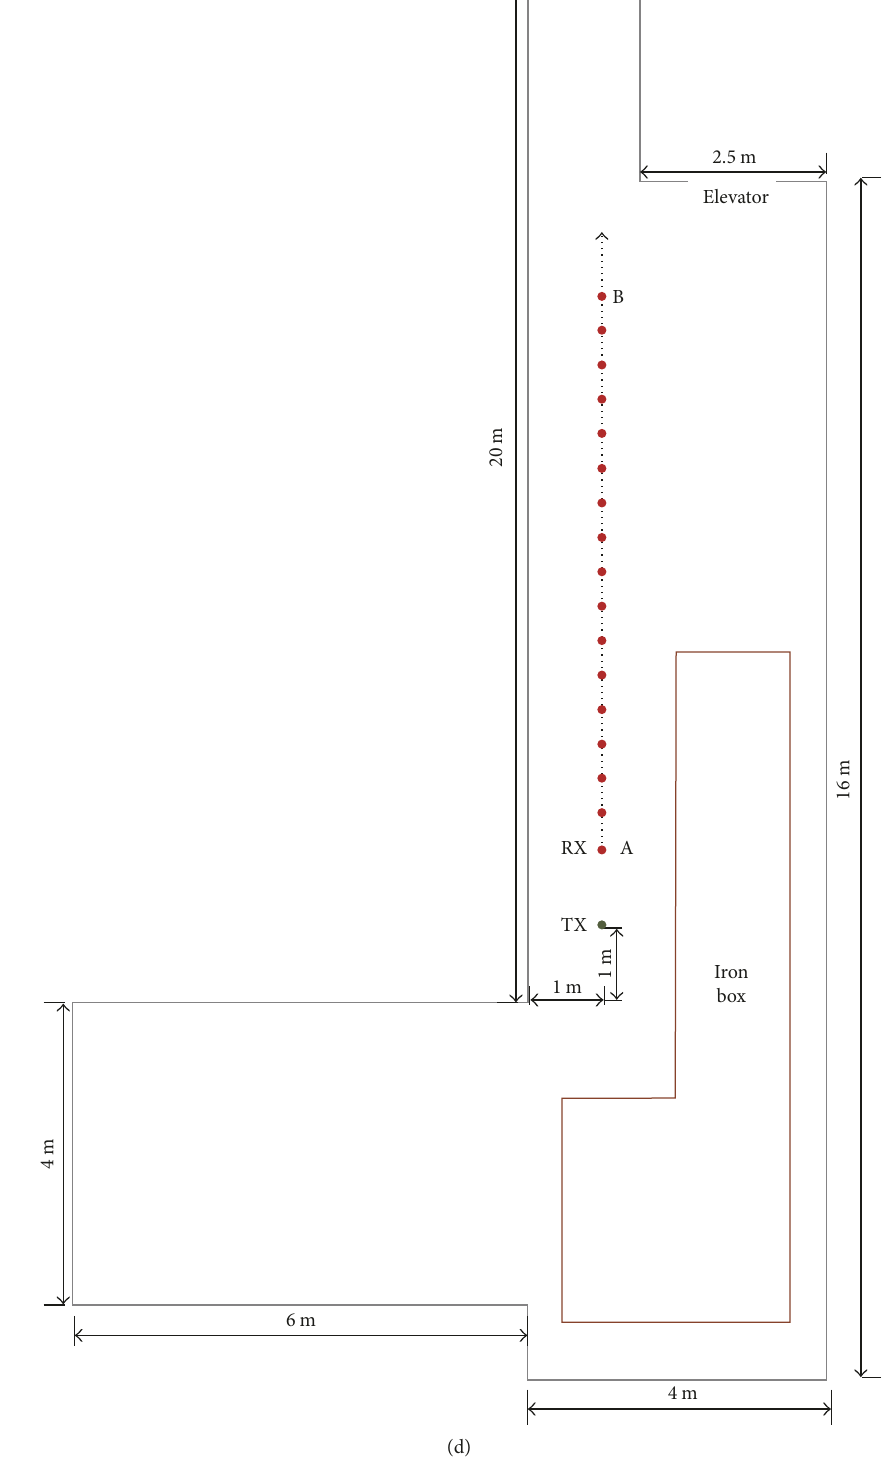
Figure 2: Measurement environment. (a) Photo of tunnel scenario 1, (b) photo of tunnel scenario 2, (c) sketched plan of tunnel scenario 1, and (d) sketched plan of tunnel scenario